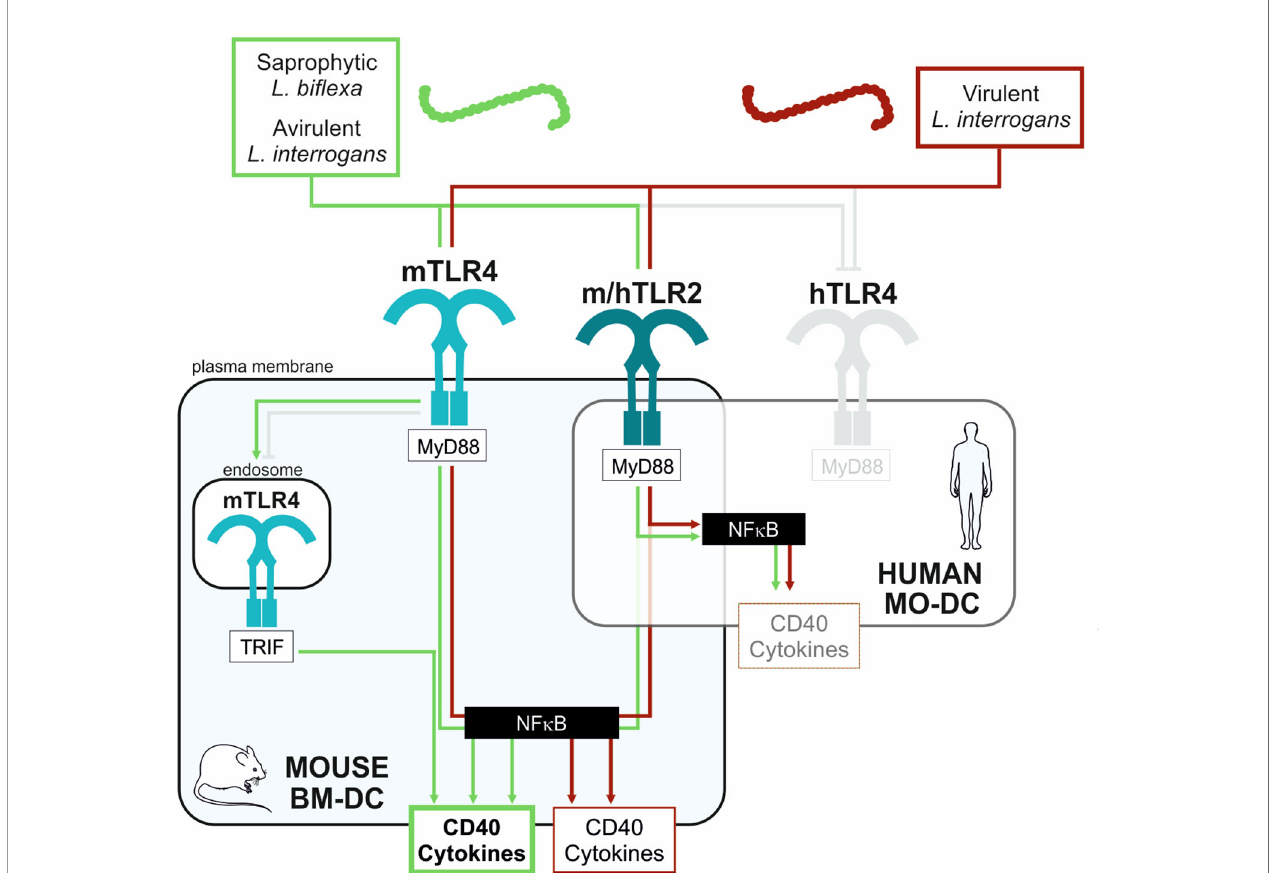
FIGURE 7 | Schematic proposed model of mouse and human DCs activation upon stimulation with virulent compared to avirulent pathogenic strains of leptospires. Simpli fi ed model to explain the differential activation pro fi les in mouse (BM-DC, light blue frame) and human (MO-DCs, transparent frame) dendritic cells upon stimulation with leptospires. Saprophytic and avirulent strains of leptospires (green box) trigger a strong activation of mouse DCs since they activate 3 pathways: the murine (m)TLR4/MyD88, the endosomal mTLR4/TRIF, and the mTLR2/MyD88 pathways, all converging to the central NF- k B transcription factor, important for upregulation of activation markers (CD40) and cytokines production. In contrast, the virulent leptospires (red box) only stimulate 2 pathways in mouse DCs: the mTLR4/MyD88 and mTLR2/MyD88 pathways. The escape from the mTLR4/TRIF pathway by virulent leptospires (also evidenced in macrophages (20)) is depicted (grey capped line). Hence, the upregulation in CD40 and cytokines by virulent strains is lowered compared to avirulent strains. Finally, since leptospires are not recognized by the human (h)TLR4 (13, 14) (grey capped line), leptospires would activate the human DC mainly through the hTLR2/MyD88 pathway, which could explain both the low activation of DC by leptospires and the lack of differences between virulent and avirulent